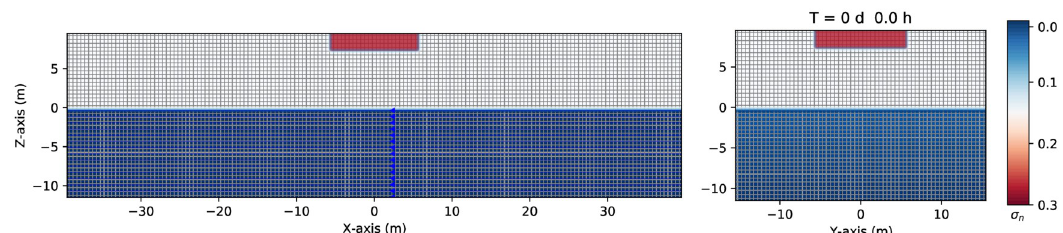
Fig 1. Three-dimensional numerical grid geometry. Example of the grid geometry used in the numerical simulation of a three- phase fluid flow (water + LNAPL + air) with a spatial grid resolution of 0.50 m and a grid dimension of 80 m × 32 × 22 m , at the initial time t = 0 s . The red box is the continuous source of an immiscible contaminant at the top of the parallelepiped in the z − x plane (left-hand side) and the z − y plane (right-hand side),